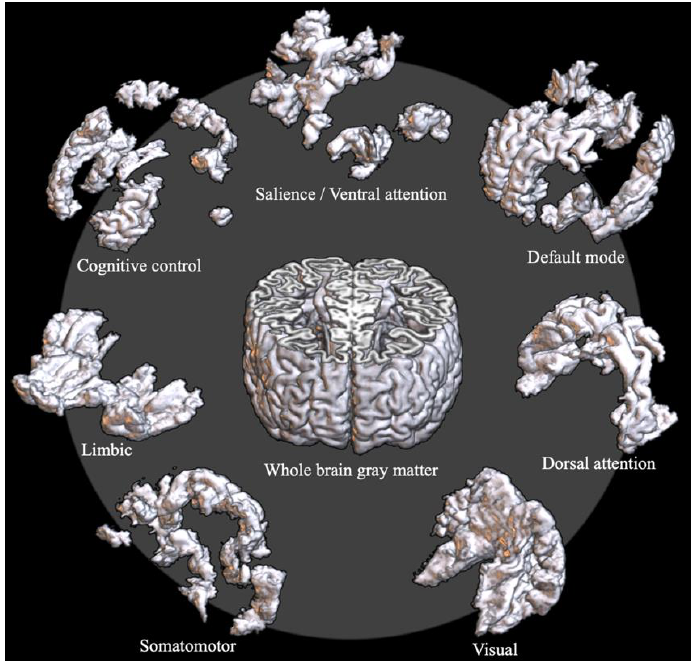
Figure 1. Exemplar T1 image of the segmented whole-brain grey matter (GM) volume and the intrinsic connectivity network (ICN)-level GM volumes. The ICN-level GM volumes were obtained by masking the whole-brain GM volume with the seven ICNs of the Schaefer 400 atlas.